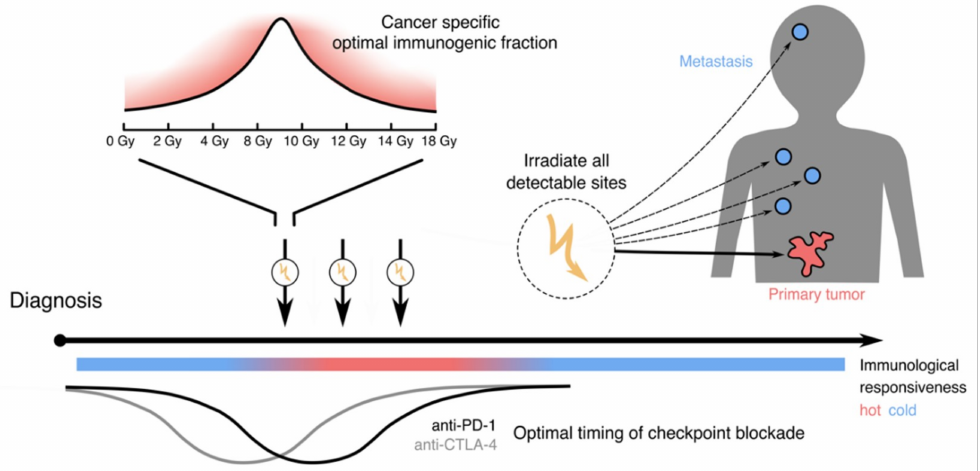
Figure 2. Combination of external beam radiotherapy and immune checkpoint inhibiting antibodies. The optimal timing of immune checkpoint inhibition appears to be in the early phase of radiotherapy. Preclinical models indicate that cytotoxic T-lymphocyte-associated protein 4 (CTLA-4) blockade may be more e ff ective when administered days before irradiation. The optimal dose of radiation as determined in mouse models is indicated. The red gradient indicates suggested variability in cancer-specific clinical settings. Preliminary clinical studies have reported improved outcomes when irradiating multiple